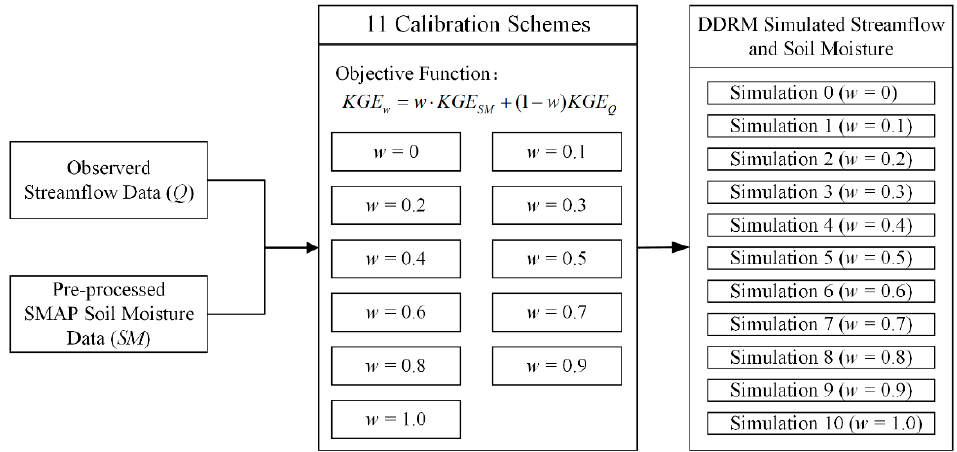
Figure 3. Eleven calibration schemes for DDRM using both streamflow and the SMAP soil moisture data.